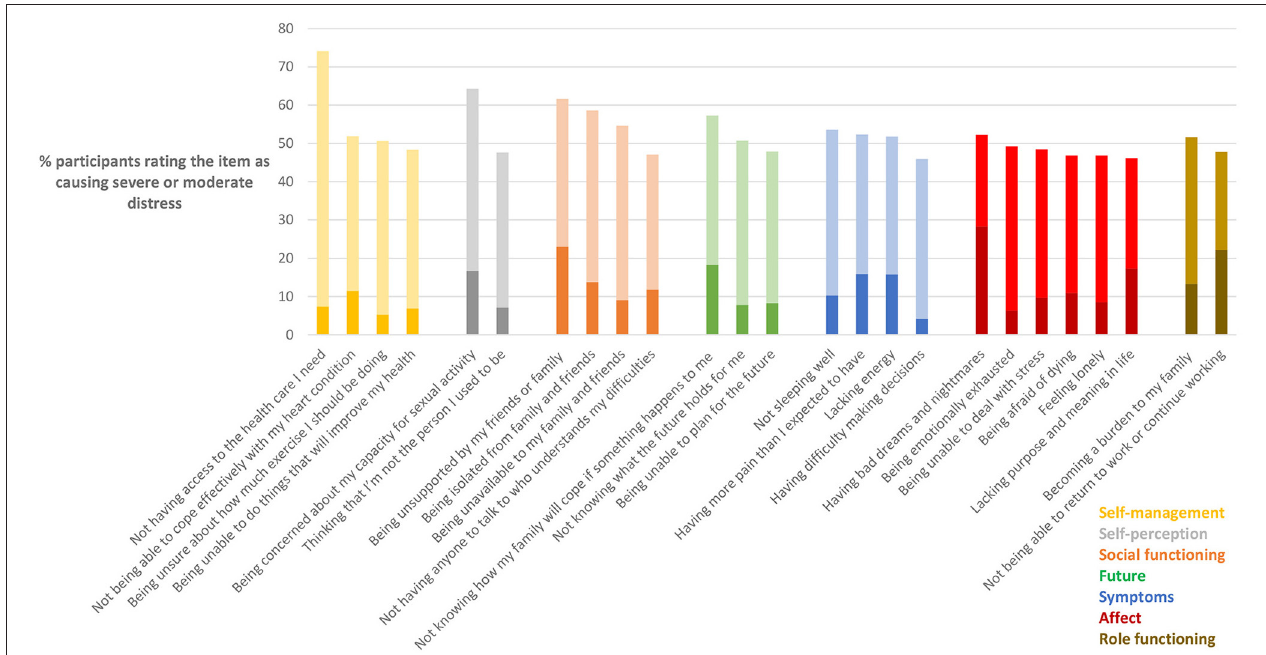
FIGURE 2 | Issues and concerns rated as severely or moderately distressing. N = 189–194 with variations due to incompletions in some questionnaires. Dark color indicates rating of “severe” distress, light color indicates rating of “moderate distress.” Only 25 most distressing items